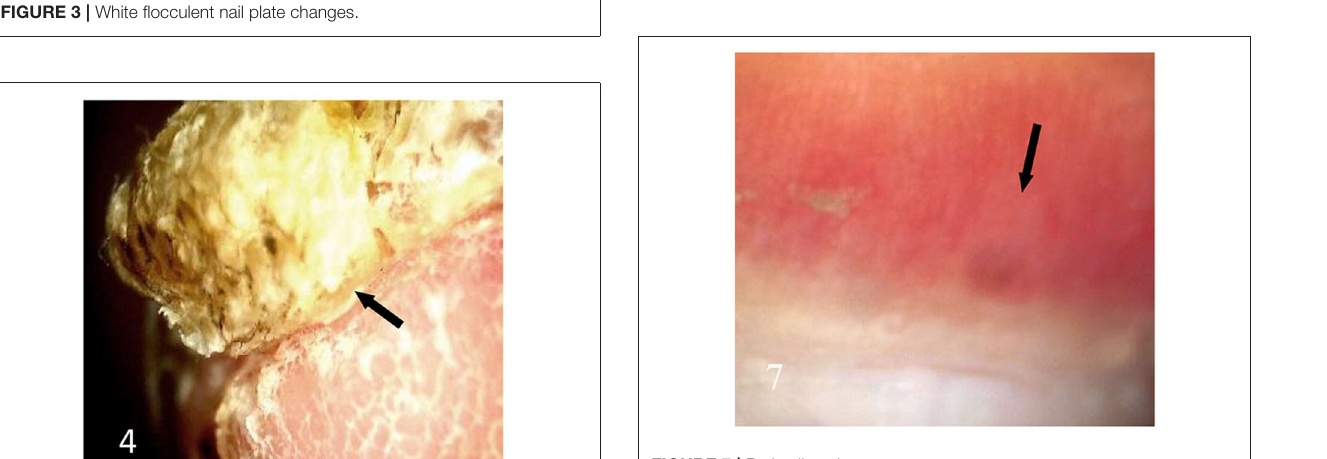
FIGURE 7 | Peri nail